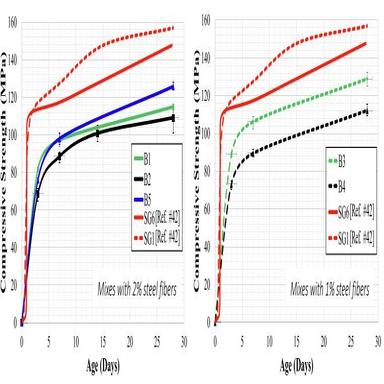
Compressive strength versus time for mixes with 2% (left) and 1% (right) steel fibers.